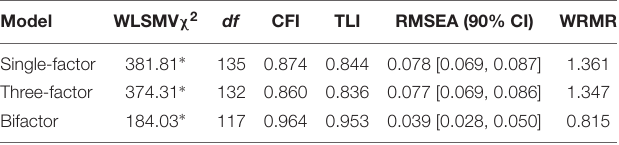
TABLE 2 | Goodness-of-fit indices for the three tested models of the